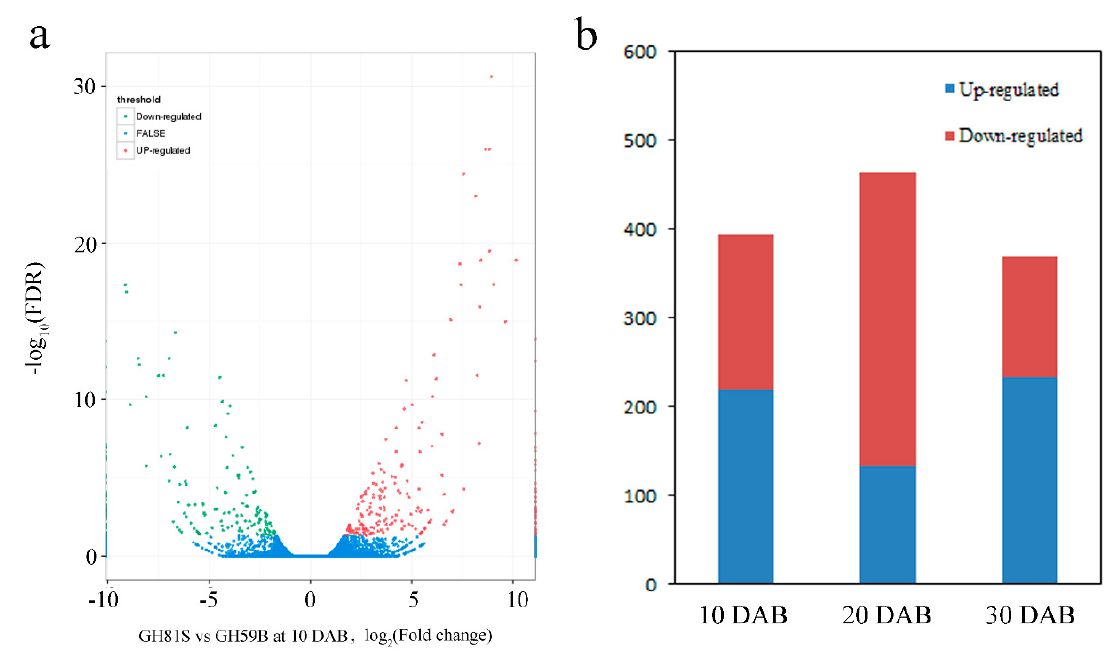
Figure 3. Statistics of differently expressed genes. ( a ) Significantly up- or downregulated genes using the threshold of FDR ≤ 0.001 and log 2 Ratio ≥ 1 in GH81S vs. GH59B at 10 DAB. ( b ) Number of upregulated and downregulated transcripts in three stage of fruit development.